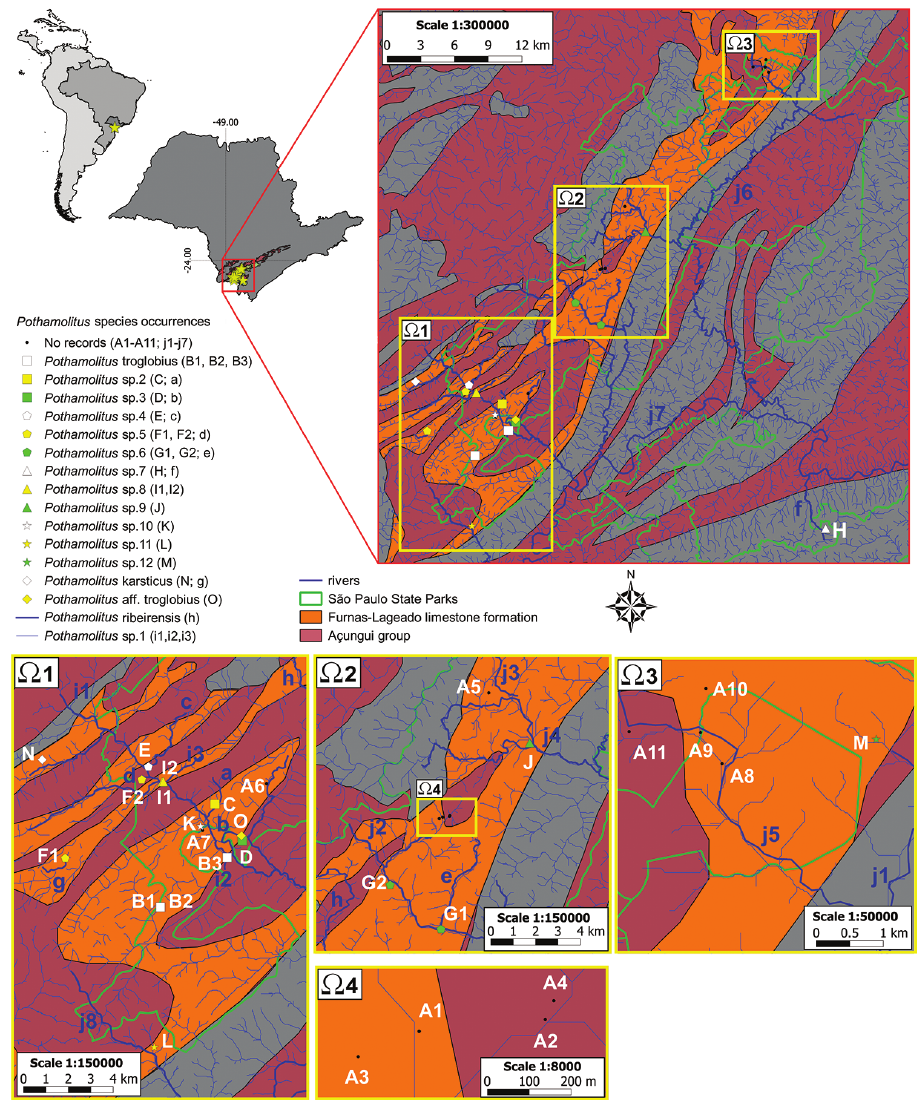
Figure 1. Map showing the surveyed localities (basins, microbasins and caves) from Alto Ribeira karst area, Southeastern Brazil. Some localities are approximated (*) (Author: DM von Schimonsky). Caves : A1 –